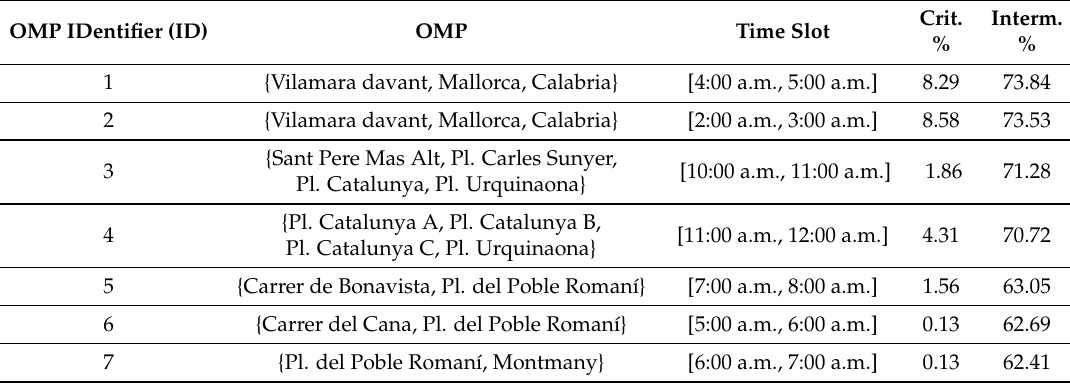
Table 3. Bicing (Barcelona). Groups of stations with maximal intermittence in different hourly time